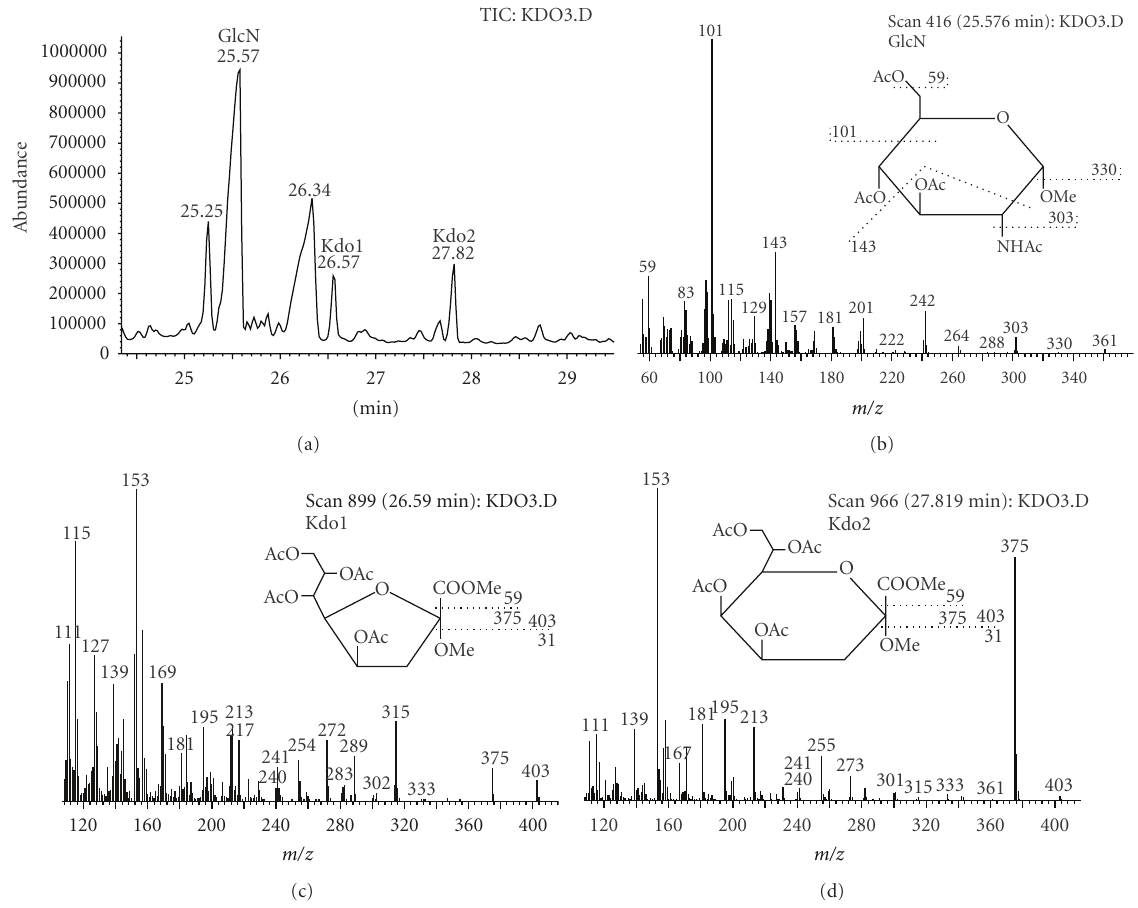
Figure 3: Chromatogram and mass spectra of glucosamine and Kdo methyl glycoside originated from LPS of D. desulfuricans .